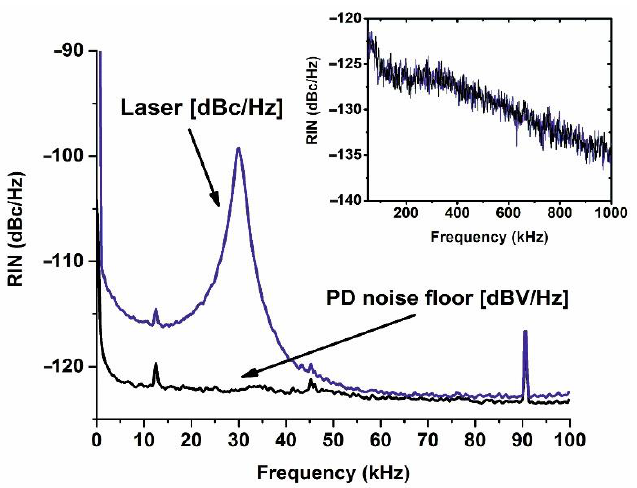
Figure 4. RIN of the chirped-pulse USP fiber laser and the receiving system noise floor. Inset: RIN in the high-frequency range.